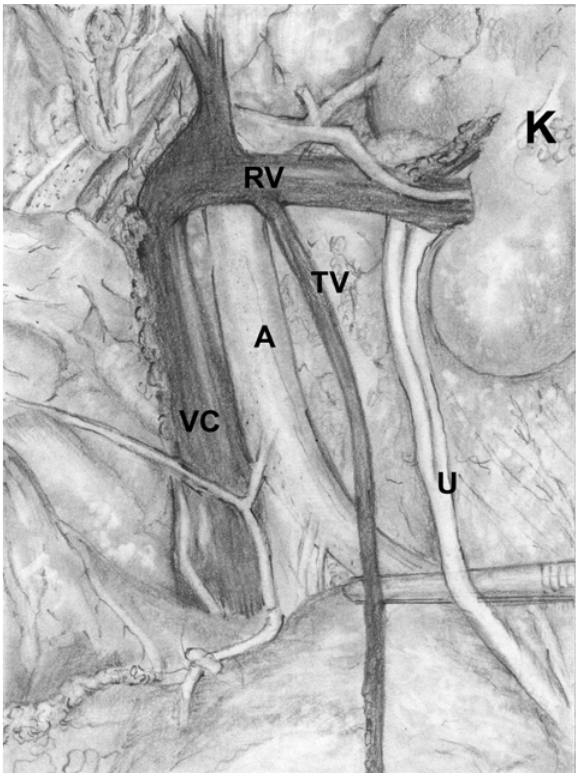
Figure 3 – Schematic drawing highlights a cadaver where there is no division of the left testicular vein (TV), which drains in a straight angle at the left renal vein (RV). VC = inferior vena cava, A = aorta, U = ureter; K = kidney.